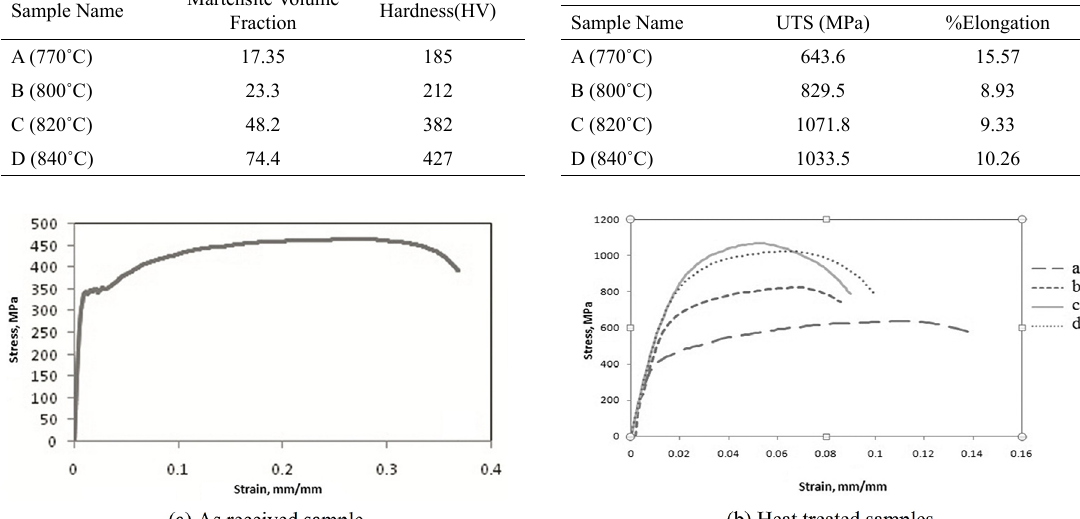
Table 3. UTS and %Elongation of the DP